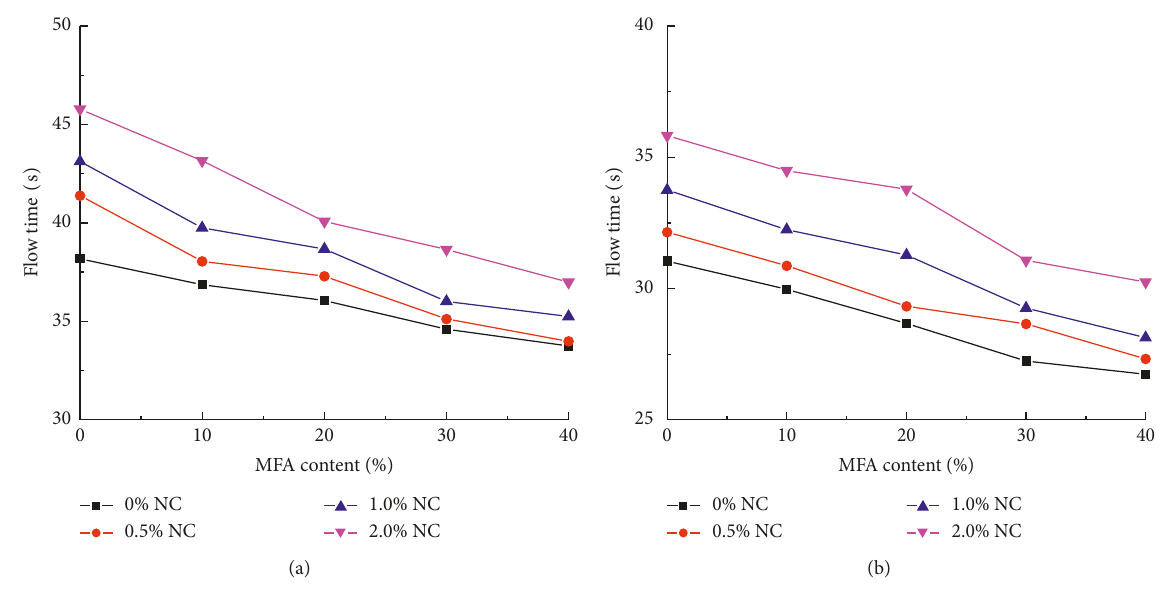
Figure 5: Flow times of fresh grouts with a W/S ratio of 1.2: (a) 0% SP; (b) 1.5%